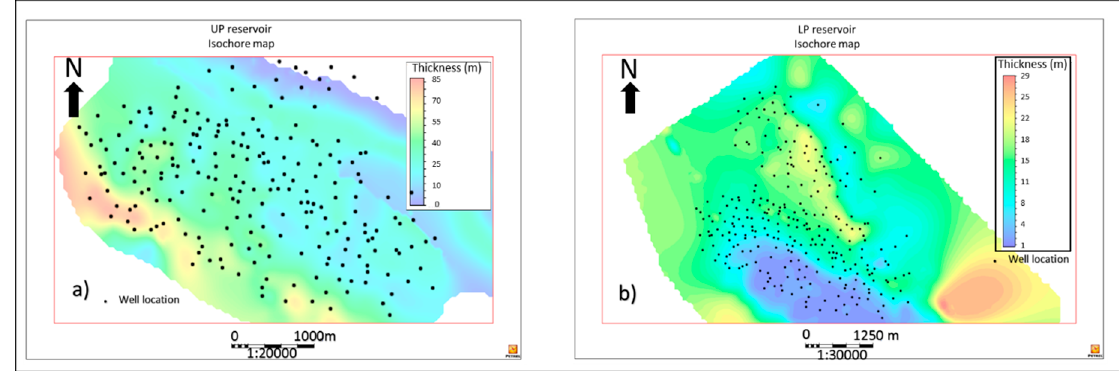
Figure 7. Isochore map of the ( a ) “UP” reservoir and ( b ) “LP” reservoir.